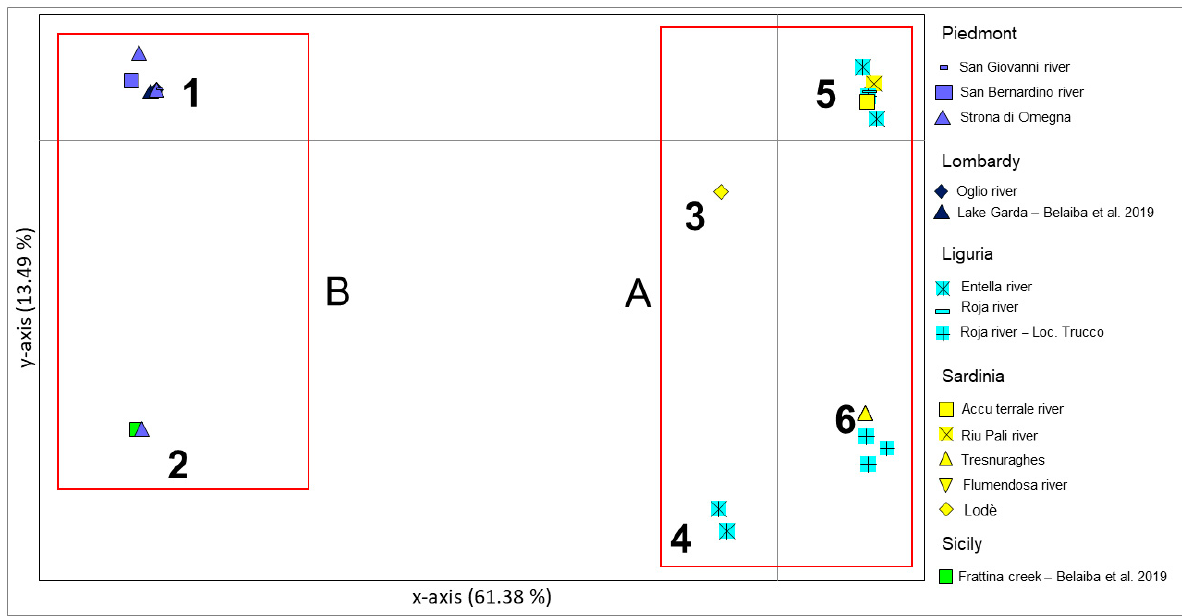
Figure 3. Principal coordinates analysis performed on Italian sequences from the present study and also from a previous study [15]. Bidimensional plot shows the genetic differentiation among specimens due to the nucleotide substitutions per site found in the dataset. Belaiba et al., 2019 in the legend corresponds to the reference [15].